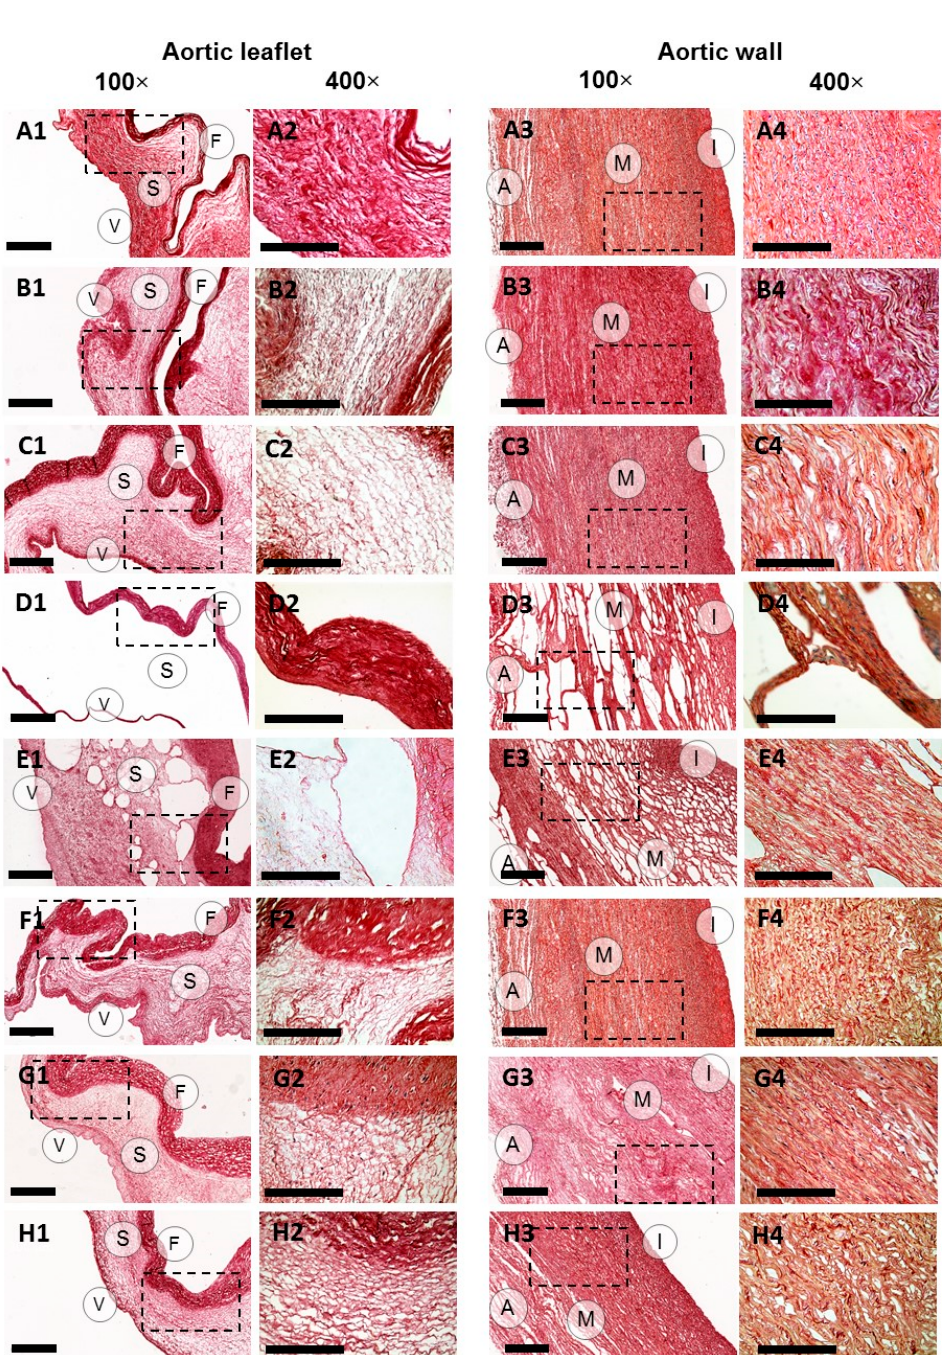
Figure 2. Collagen content in aortic valve leaflets and walls of native ( A1–4 ) and decellularized ovine aortic roots. Decellularization protocols included scCO 2 -assisted processing at the pressure of 15 MPa ( B1–4 ) and 25 MPa ( C1–4 ) with the use of ethanol as a co-solvent; combinations of alkaline treatment with scCO 2 -assisted processing at the pressure of 10 MPa ( D1–4 ) and 15 MPa ( E1–4 ); detergents alone ( F1–4 ) or with following scCO 2 treatment at the pressure of 15 MPa ( G1–4 ) and 25 MPa ( H1–4 ). The collagen fibers were stained red with Picrosirius red. Dashed lines mark the areas where the 400 × images were acquired. 100× scale bar = 100 µm; 400× scale bar = 300 µm.